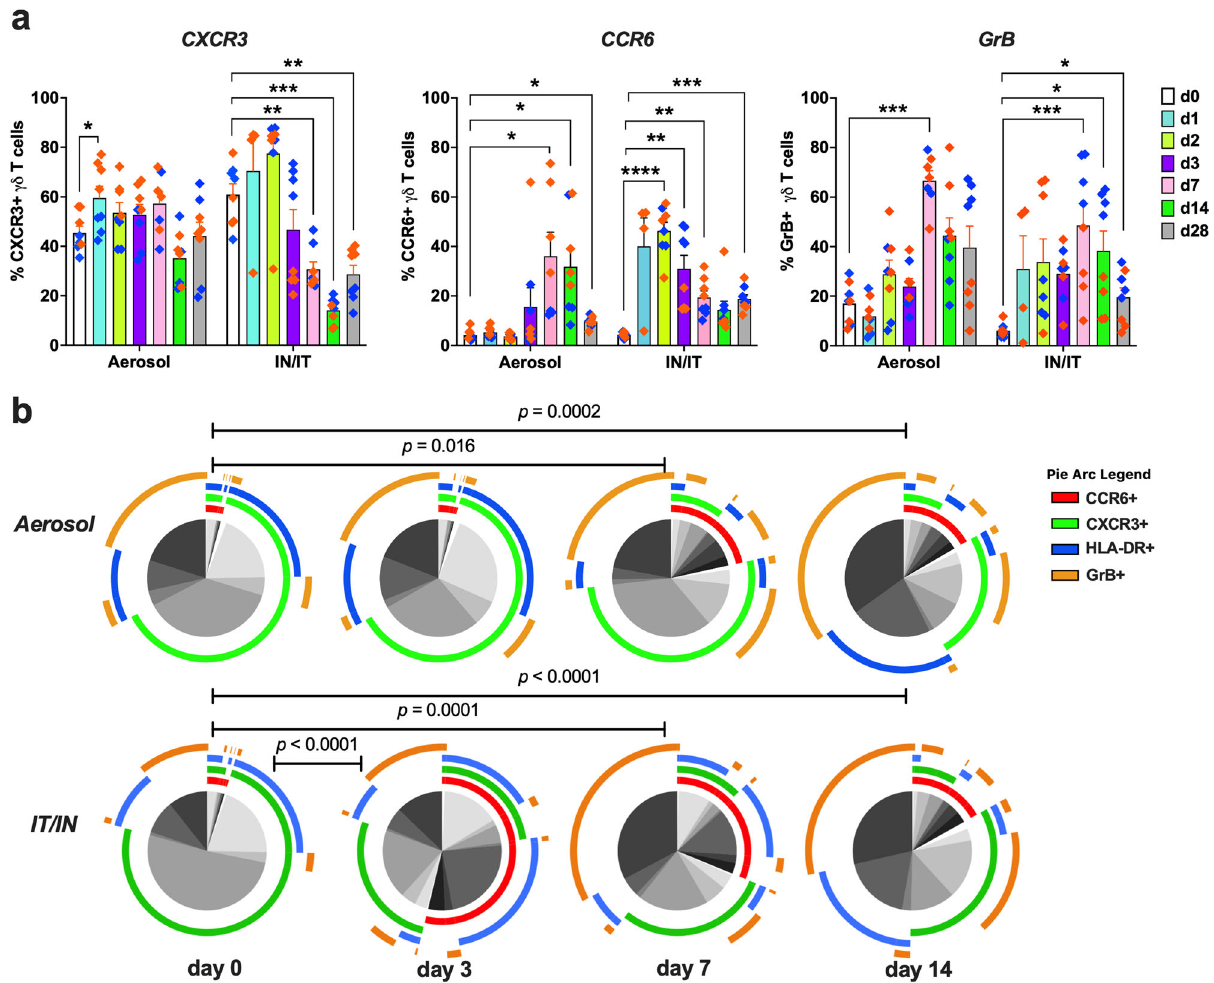
Fig. 4 Differential increase in circulating γδ T cell GrB and CCR6 expression between aerosol and IT/IN routes of SARS-CoV-2 infection. a Frequencies of CXCR3 + , CCR6 + , and GrB + γδ T cells in PBMC of aerosol versus IT/IN exposed RMs (orange diamonds) and AGMs (blue diamonds) through the course of one month SARS-CoV-2 infection ( n = 8/group). Graphs show mean and SEM. Comparisons of different time points with respect to d0 baseline data were done using two-way ANOVA with mixed effects model and Dunnett ’ s post hoc tests. Asterisks indicate signi fi cant differences between time points (* p < 0.05; ** p < 0.01). b Pie charts comparing early changes in polyfunctional γδ T cell phenotype from baseline till 2 weeks of infection in the aerosol and IT/IN groups based on the expression of HLA-DR, CXCR3, CCR6, and GrB. The arcs around the circumference indicate each marker expressed by the proportion of cells that lie under the arc. HLA-DR is shown in blue, CCR6 in red, CXCR3 in green, and GrB in orange. p values were computed using the SPICE permutation